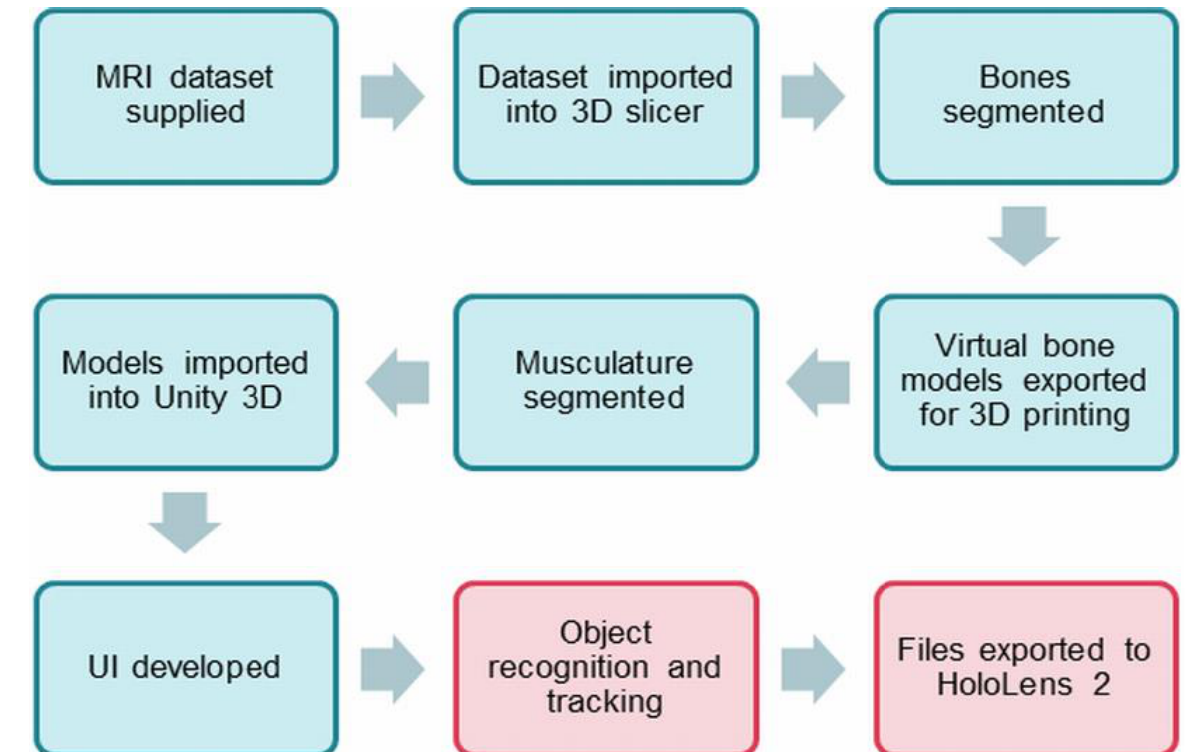
Figure 1. Process diagram involved in the study. Red sections refer to the steps that are ongoing for further development.